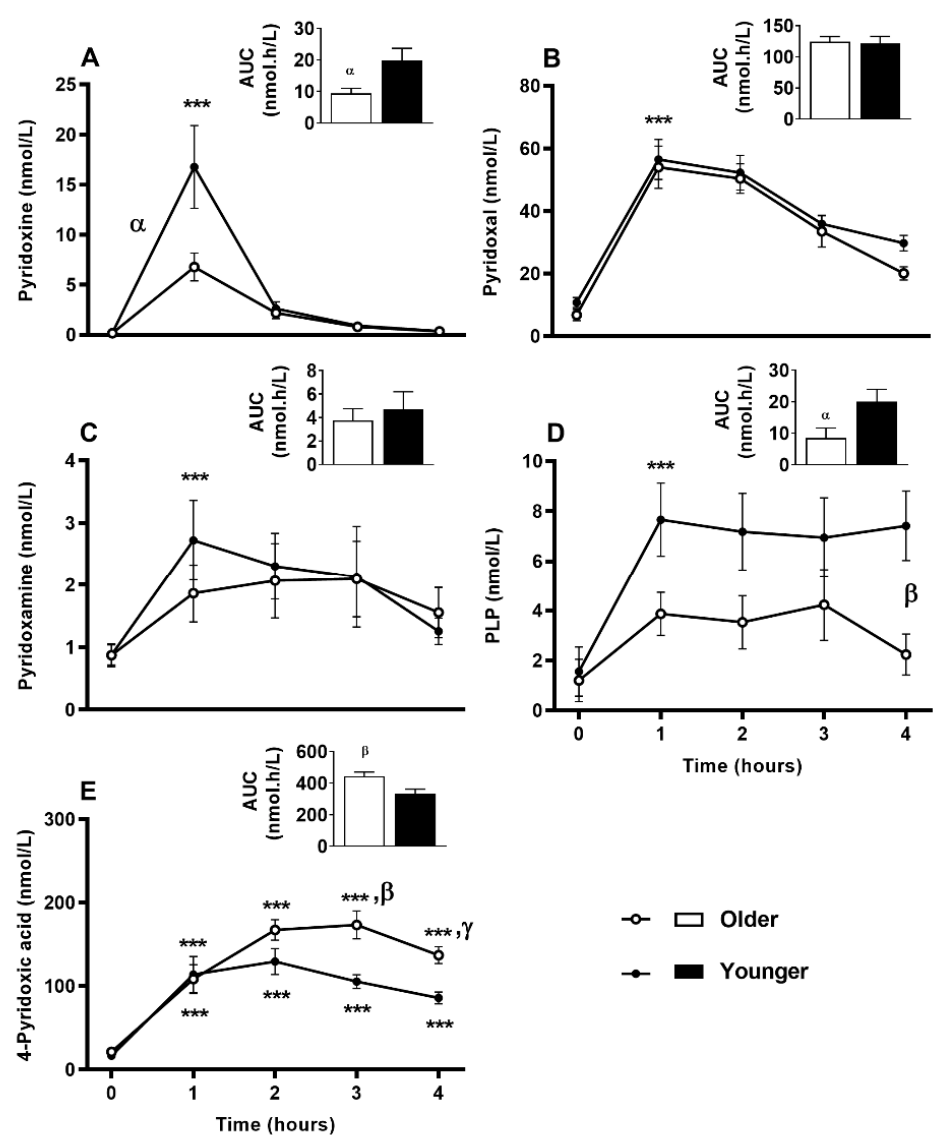
Figure 3. Plasma response of B 6 vitamers at fasting (time, 0), hourly until 4 h (time, 1, 2, 3, 4) and the four hour incremental area under the curve (AUC, represented by bar-graphs) following a single multivitamin and mineral supplement ingestion in older and younger adults. ( A ), Pyridoxine ( B ), pyridoxal ( C ), pyridoxamine ( D ), pyridoxal 5 (cid:48) -phosphate (PLP), and ( E ) 4-pyridoxic acid. Data for multiple time points was compared using general linear mixed model with time as repeated and age as fixed factor. AUC data was compared with general linear univariate analysis of variance with age as fixed factor. Sidak post hoc test was applied for pairwise comparisons if significant interaction was present. ***, p < 0.001, significant increase following supplement intake relative to baseline in both age groups. The older adults had decreased postprandial increase in pyridoxine (age e ff ect p < 0.035, time e ff ect p < 0,001) and PLP (age e ff ect p = 0.009, time e ff ect p < 0.001) but increased 4-pyridoxic acid (age × time, p = 0.002) than the younger adults ( α , p < 0.05; β , p < 0.01; γ , p < 0.001, main age di ff erence or di ff erence with age × time interaction at particular time points).